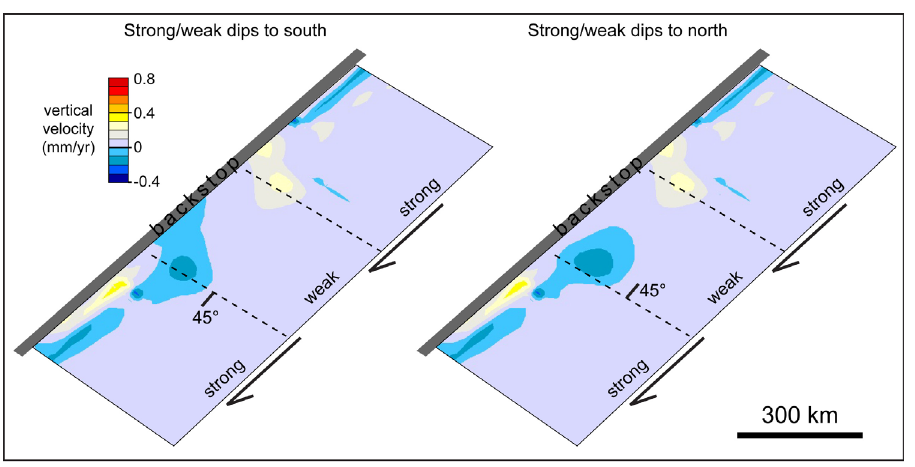
Figure 9. Sensitivity analysis of model shown in Figure 8d varying the dip of the boundary between the strong and weak mid-crust in the south; ( a ) The rheological boundary dips 45° to the south; ( b ) The rheological boundary dips 45° to the north. These models produce slightly different shapes to the zone of subsidence otherwise the models are not very sensitive to the dip of the rheological